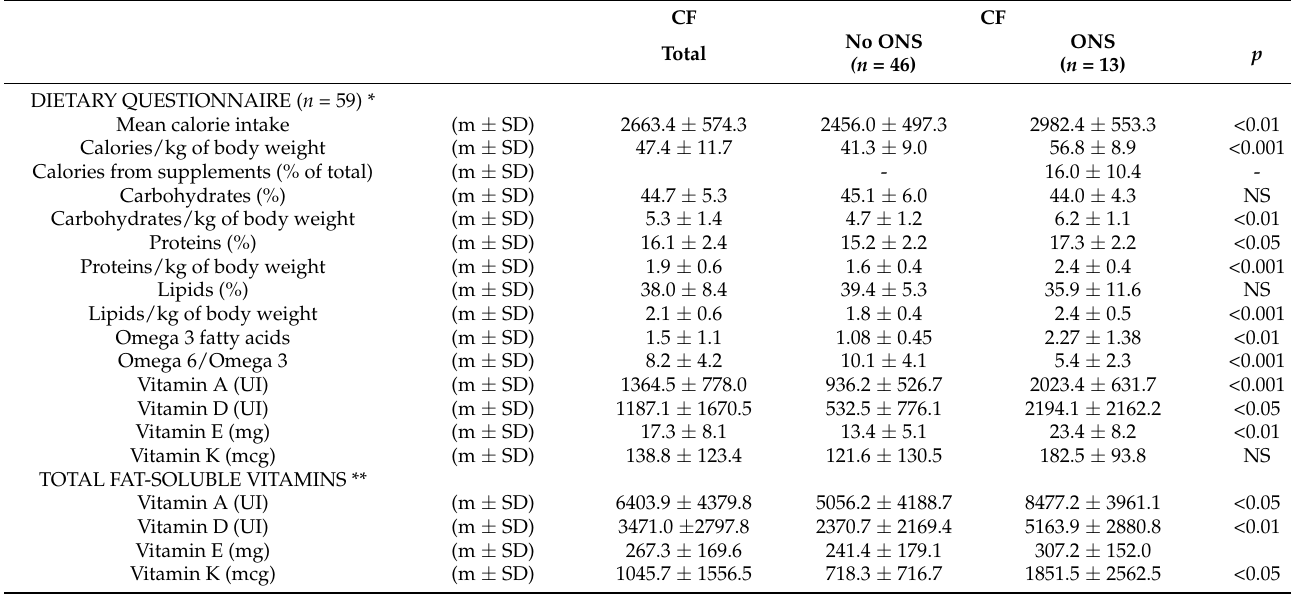
Table 3. Dietary questionnaire and fat-soluble vitamin supplementation. Association between dietary questionnaire and ONS intake.